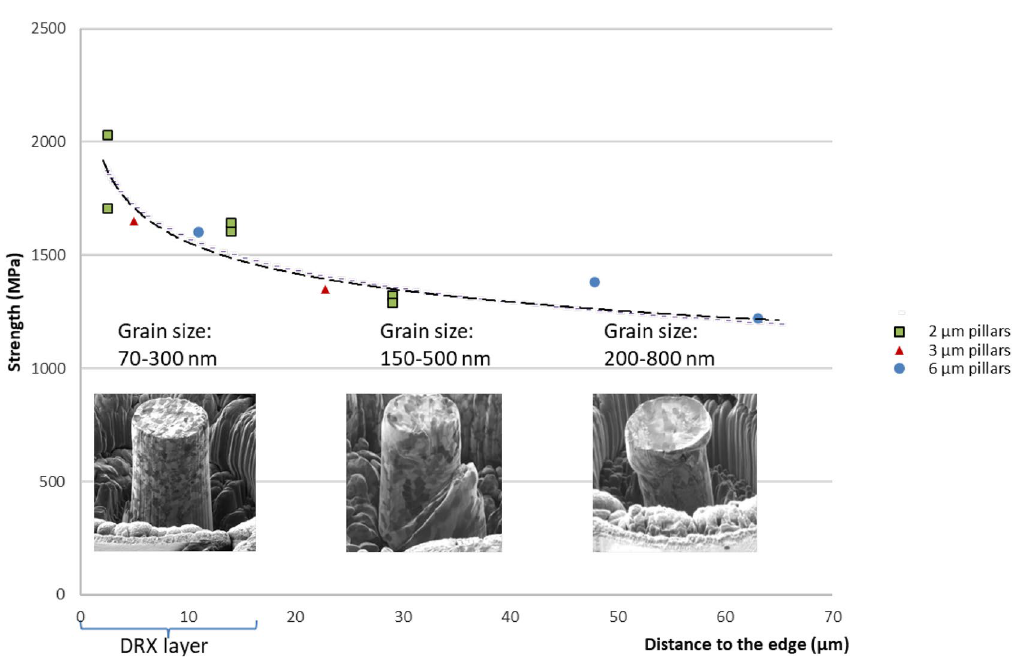
Figure 4. Strength values obtained by pillar compression tests of the pillars of 2, 3 and 6 µm of diameter milled on a cross-section at different depth into the material. Pillar diameter does not have notable influence, however pillar closer to the edge show larger